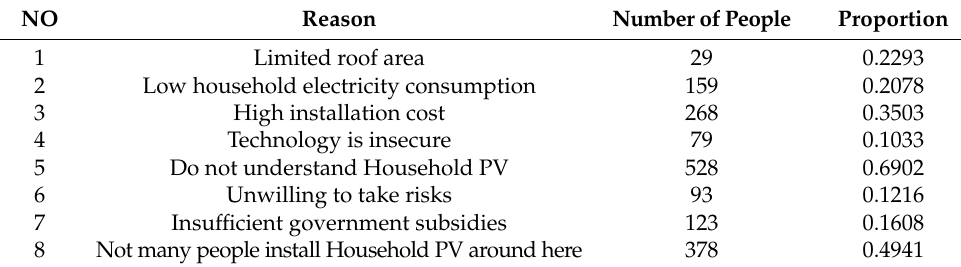
Table 6. Reasons for not installing Household PV.